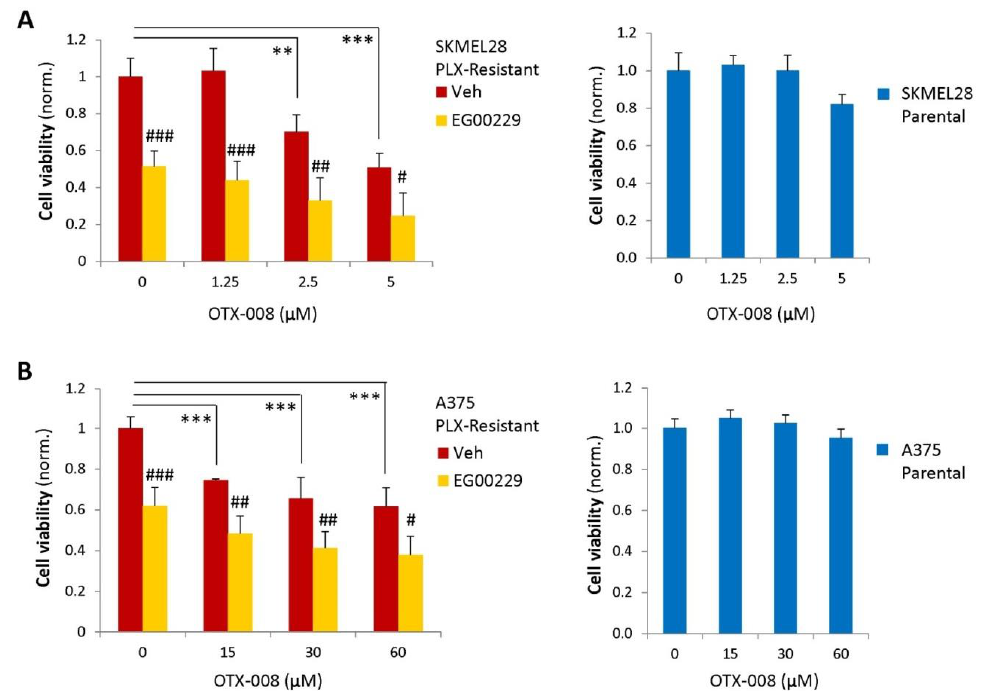
Figure 5. Gal-1 inhibition restores the efficacy of BRAF-targeted therapy in drug-resistant